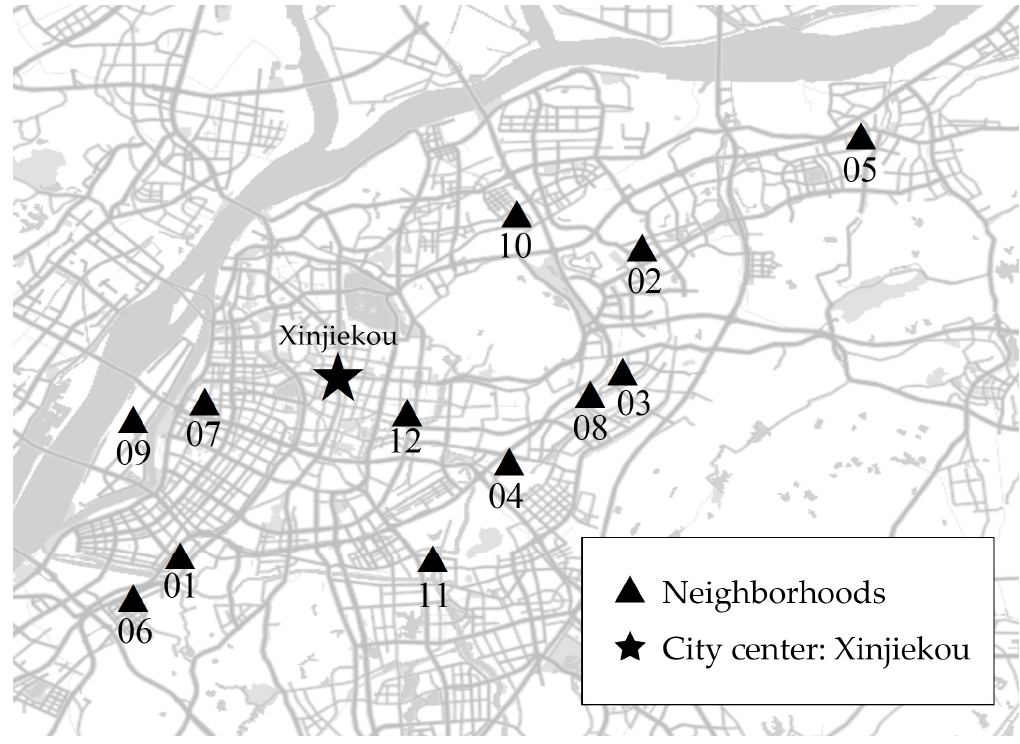
Figure 2. The distribution of surveyed neighborhoods. Table 1. Basic characteristics of surveyed neighborhoods.